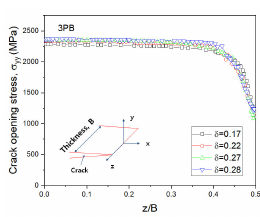
Figure 9. Opening stress distributions from FE analysis of 3PB specimens ( a ) CTOD 0.17 mm ( b ) CTOD 0.22 mm ( c ) CTOD 0.27 mm ( d ) CTOD 0.28 mm.